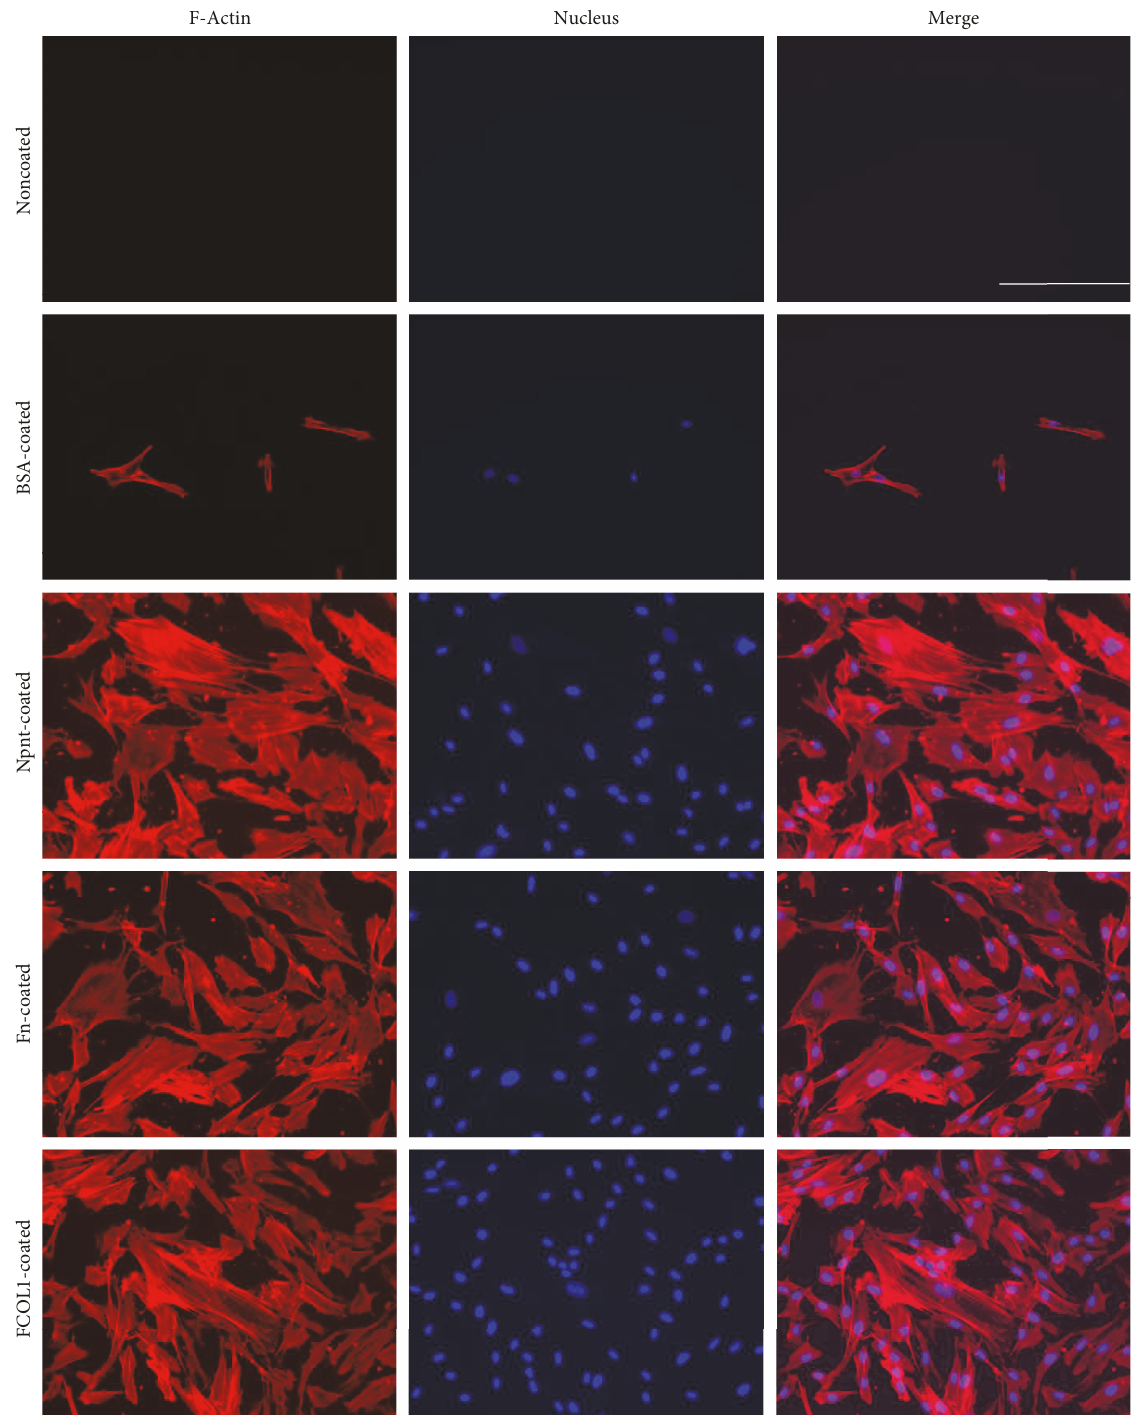
Figure 3: Organization of actin stress fi bers. Fluorescence microscopy photographs of hDPSCs that adhered and spread on polystyrene presenting Npnt. As positive controls, cells attached to substrate(s) having adsorbed layers of Fn and FCOL1. Actin stress fi bers were visualized with Alexa Fluor 568-conjugated phalloidin (red-orange), and nuclei were visualized with DAPI (blue). The scale bar in merge photo of noncoated group applies to all panels (scale bar: 200 μ